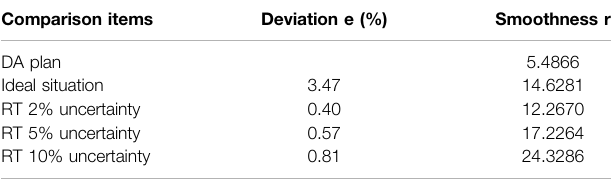
TABLE 4 | Deviation index and smoothness